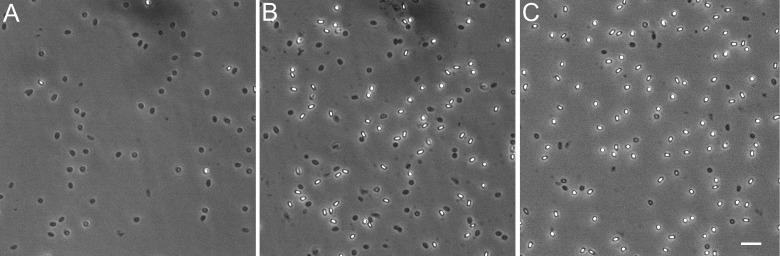
Phase-contrast microscopy of germinating B. subtilis spore populations.Purified spores of B. subtilis wild type and mutant strains were heat-activated and stimulated to germinate by addition of 10 mM L-Val followed by incubation at 37°C for 60 mins. A) PS832 B) ytpA mutant strain C) ylbC mutant strain All panels are the same magnification; the bar in panel C is 5 μm.